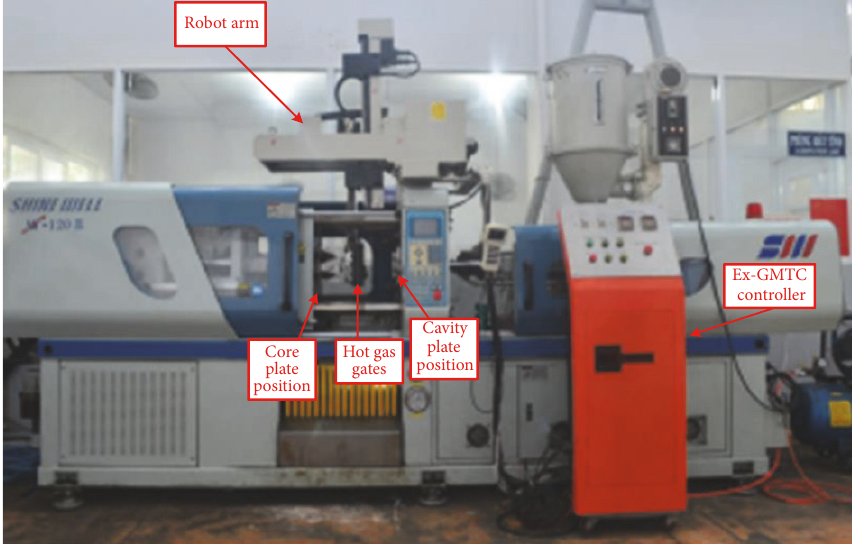
Figure 6: External gas-assisted mold temperature control experiment